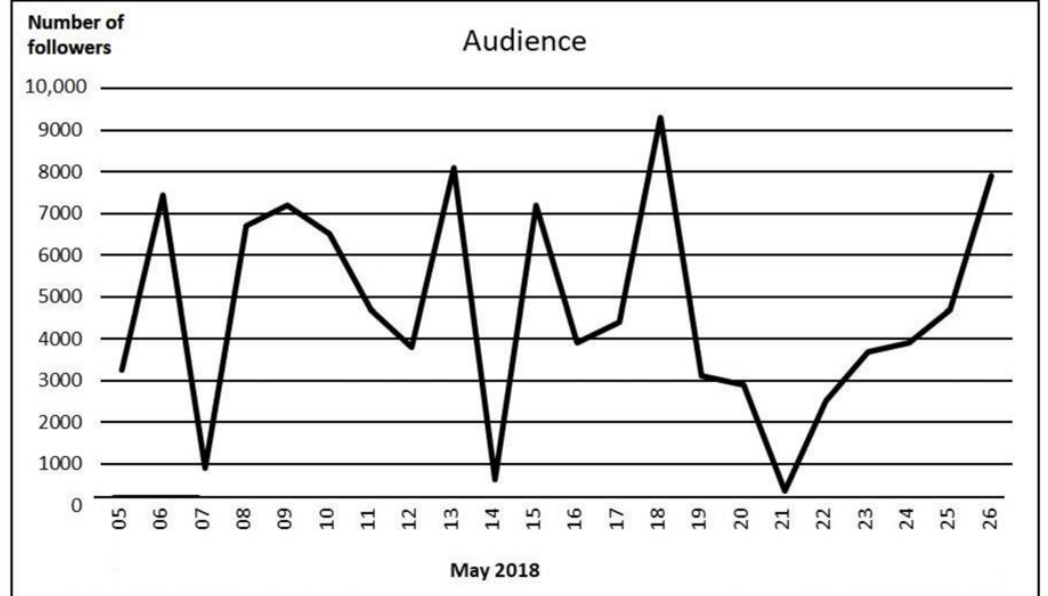
Figure 8. Audience data of the “Repubblica delle Biciclette” social media channel, referring to the geology and cycling events’ followers, at the Calanchi bike marathon (May 6) and at the Giro d’Italia special interviews on the geological settings of the